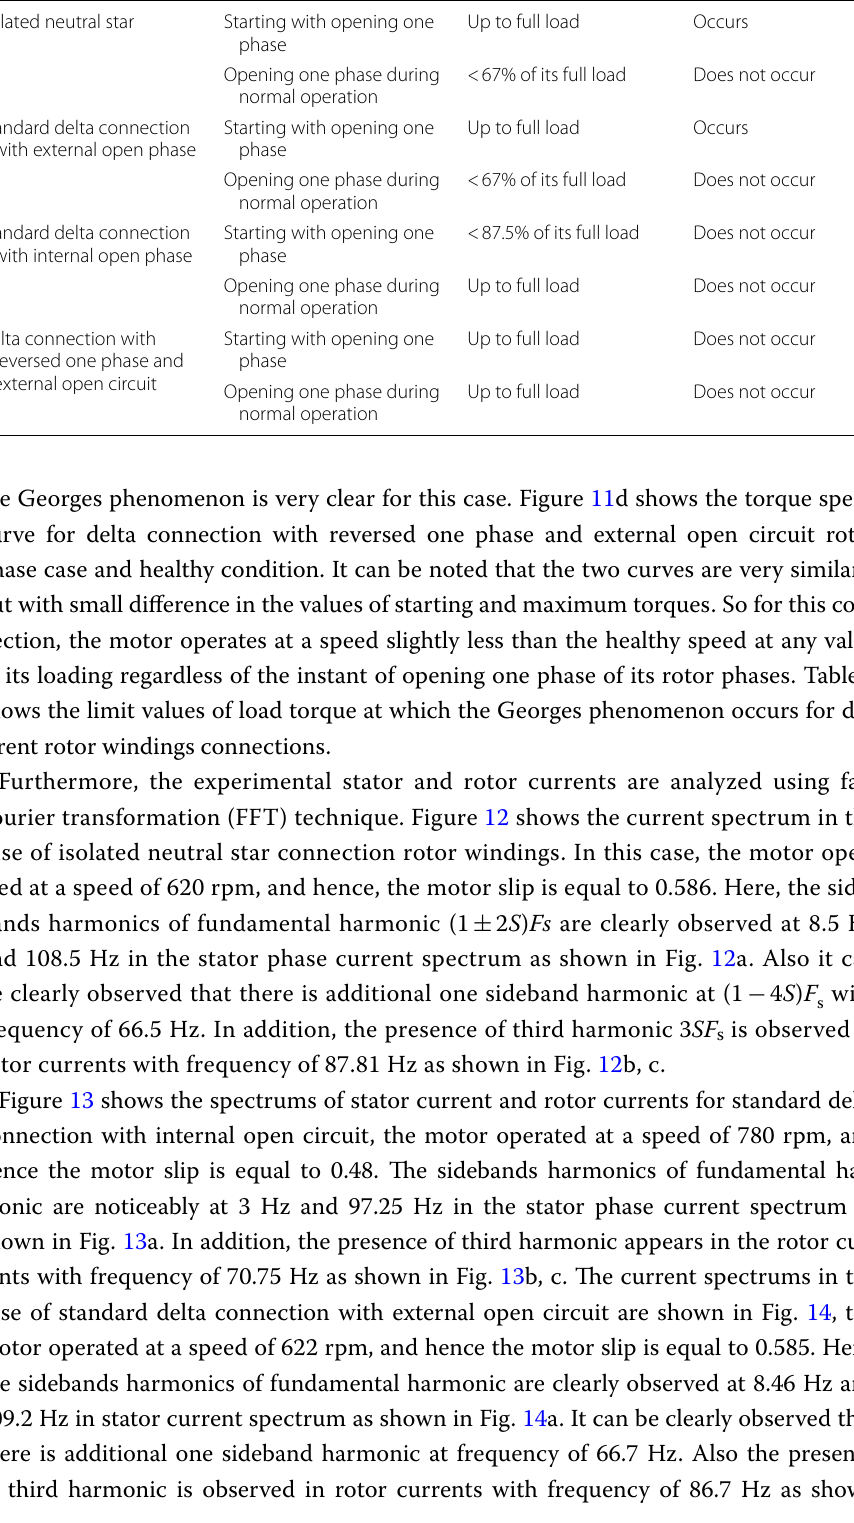
Table 2 Torque limits of the occurrence of Georges phenomenon Rotor